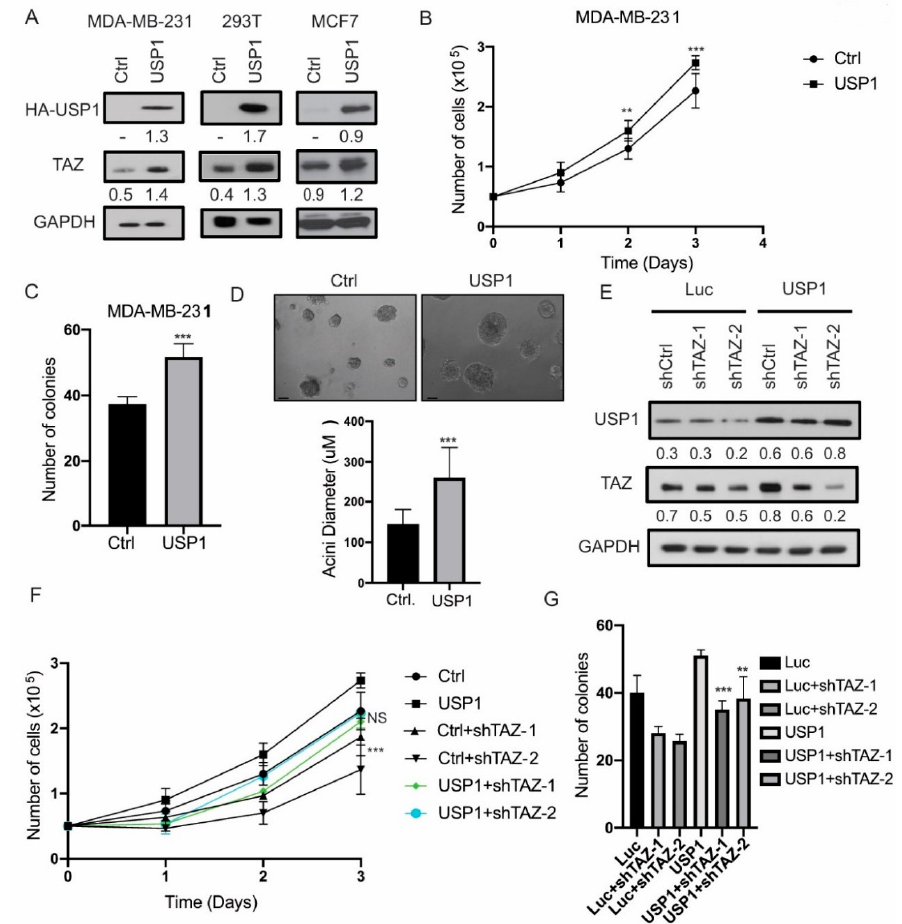
Figure 5. USP1 overexpression increases cell proliferation in a partially TAZ-dependent manner. ( A ) Immunoblot analysis for USP1 and TAZ in USP1 transduced MDA-MB-231, 293T and MCF7 cells. GAPDH was used as a loading control. ( B ) Cell proliferation assay of USP1 overexpressing MDA-MB-231 cells. ( C ) Quantification of clonogenicity assay after 11 days in USP1 overexpressing MDA-MB-231 cells. ( D ) Representative images and quantification of spheroid size in control or USP1 overexpressing MDA-MB-231 cells (Scale bar = 50 µ m). ( E ) Immunoblot analysis of TAZ knockdown in USP1 overexpressing MDA-MB-231 cells. GAPDH was used as a loading control. ( F ) Cell proliferation assay for shCtrl or shTAZ in USP1 overexpressing MDA-MB-231. ( G ) Quantification of clonogenicity assay after 11 days for shCtrl or shTAZ in USP1 overexpressing MDA-MB-231. Data are shown as the mean ± SD. Unpaired two-tailed student t-test: * p < 0.05, ** p < 0.01, *** p < 0.001. Immunoblots were quantified and normalized to